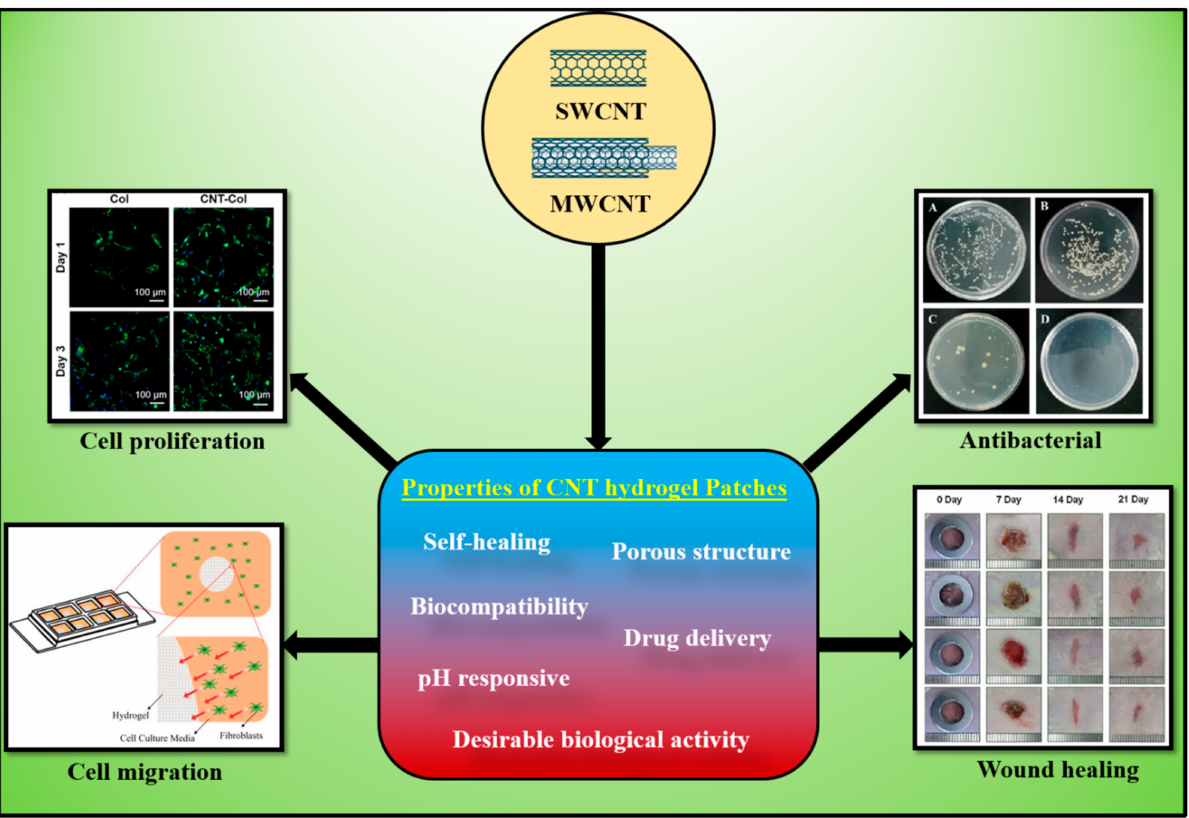
Figure 1. A scheme showing the types of CNT, properties of CNT hydrogel patches, and their application in cell prolifera- tion [34], cell migration [35], antibacterial [36], and wound healing